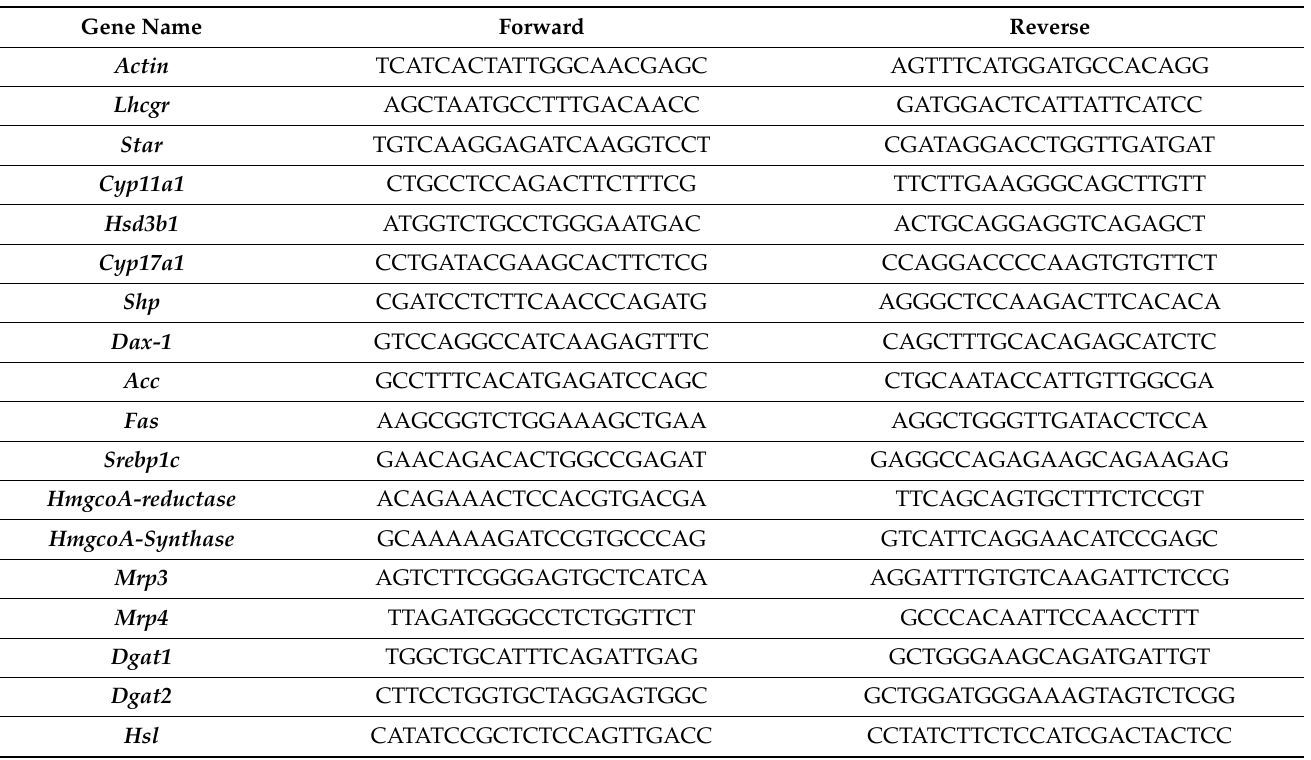
Table 1. Sequences of primers used in this